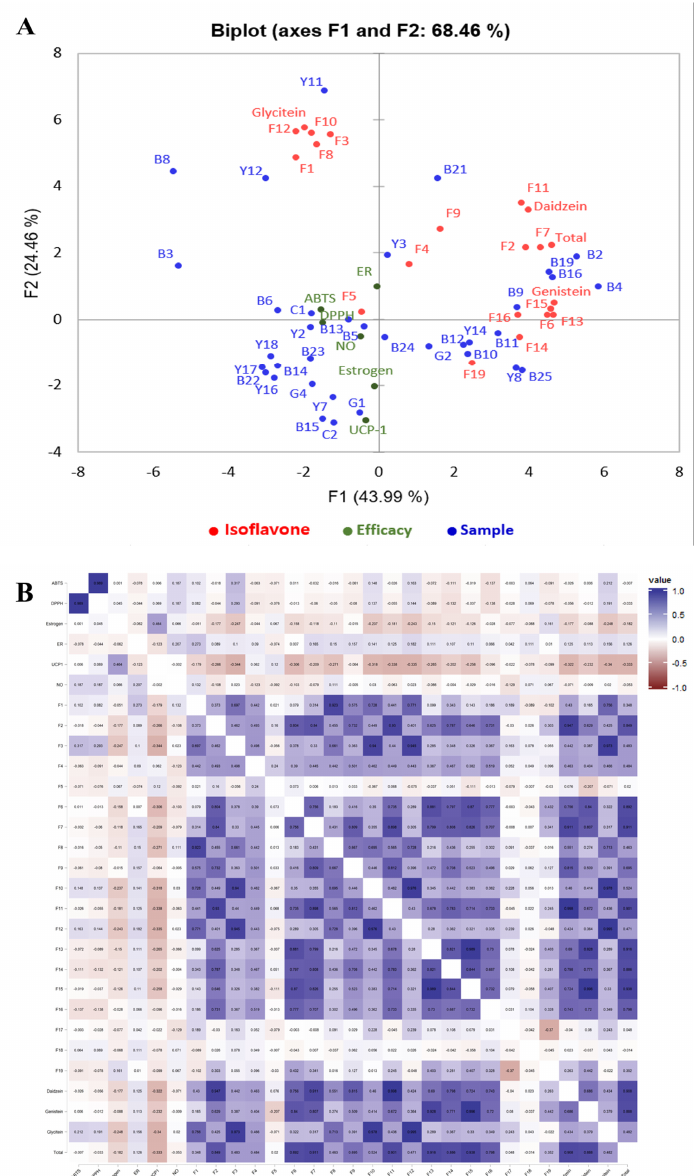
Figure 3. ( A ) Analysis of isoflavones, effects and samples by PCA. ABTS, radical scavenging activity; DPPH, radical scavenging activity; Estrogen, estrogen activity; ER − α , estrogen recep- tor alpha activity; UCP − 1, uncoupling protein − 1 activity; NO, nitric oxide inhibition activity. Control cultivar, C1 − C2; Yellow group, Y1 − Y19; Black group, B1 − B25; Green group, G1 − G4; Daidzein, daidzein group; Genistein, genistein group; Glycitein, glycitein group; Total, total isoflavone. ( B ) Correlation analysis of effects and isoflavone with soybean seed. F1, genis- tein 5- O -glucoside; F2, daidzein 7- O -glucoside (daidzin); F3, glycitein 7- O -glucoside (glycitin); F4, genistein 7- O -(6 (cid:48)(cid:48) - O -apiosyl)glucoside; F5, genistein 7- O -(2 (cid:48)(cid:48) - O -apiosyl)glucoside; F6, genis- tein 7- O -glucoside (genistin); F7, daidzein 4 (cid:48) - O -(6 (cid:48)(cid:48) - O -malonyl)glucoside; F8, genistein 5- O -(6 (cid:48)(cid:48) - O - malonyl)glucoside; F9, daidzein 7- O -(4 (cid:48)(cid:48) - O -malonyl)glucoside (4 (cid:48)(cid:48) - O -malonyldaidzin); F10, glycitein 4 (cid:48) - O -(6 (cid:48)(cid:48) - O -malonyl)glucoside; F11, daidzein 7- O -(6 (cid:48)(cid:48) - O -malonyl)glucoside (6 (cid:48)(cid:48) - O -malonyldaidzin); F12, glycitein 7- O -(6 (cid:48)(cid:48) - O -malonyl)glucoside (6 (cid:48)(cid:48) - O -malonylglycitin); F13, genistein 4 (cid:48) - O -(6 (cid:48)(cid:48) - O - malonyl)glucoside; F14, genistein 7- O -(4 (cid:48)(cid:48) - O -malonyl)glucoside (4 (cid:48)(cid:48) - O -malonylgenistin); F15, genis- tein 7- O -(6 (cid:48)(cid:48) - O -malonyl)glucoside (6 (cid:48)(cid:48) - O -malonylgenistin); F16, daidzein; F17, glycitein; F18, genistein 7- O -(6 (cid:48)(cid:48) - O -acetyl)glucoside (6 (cid:48)(cid:48) - O -acetylgenistin); F19, genistein; Daidzein, daidzein group; Genistein, genistein group; Glycitein, glycitein group; Total, total